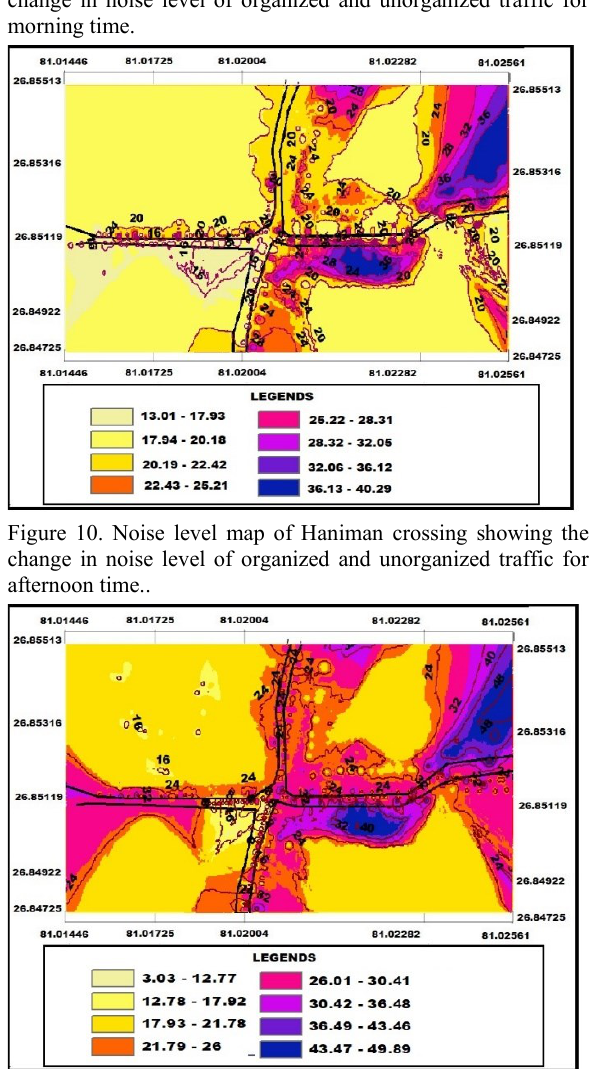
Figure 11. Noise level map of Haniman crossing showing the change in noise level of organized and unorganized traffic for evening